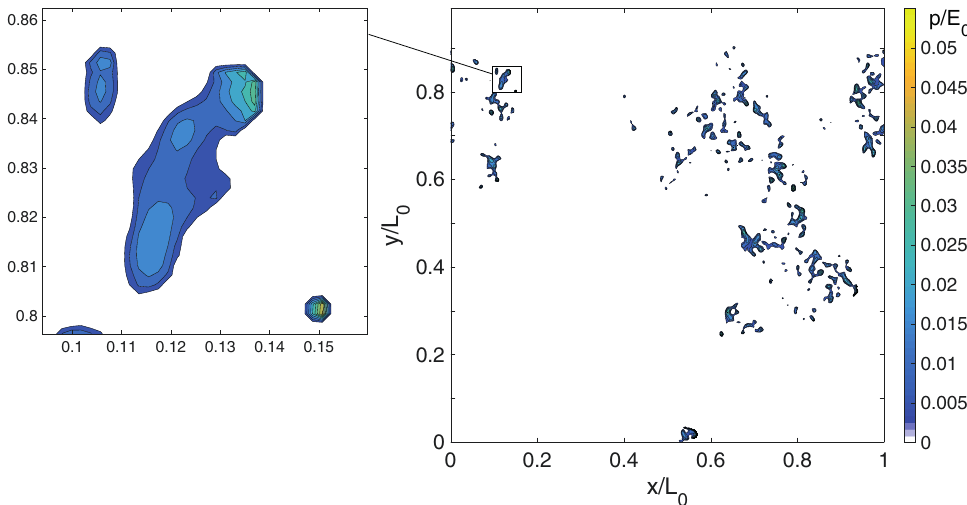
Figure 2. Contour plot of a pressure distribution for a perfectly isotropic surface sliding over a linearly viscoelastic layer. In the zoomed inset, a single patch of the contact region: this results in being stretched perpendicularly to the speed.